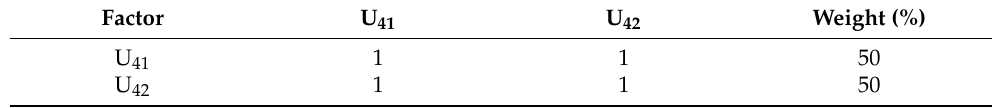
Table 8. Judgment matrix of SZSOJ’s second-level evaluation factors (U 4 ).